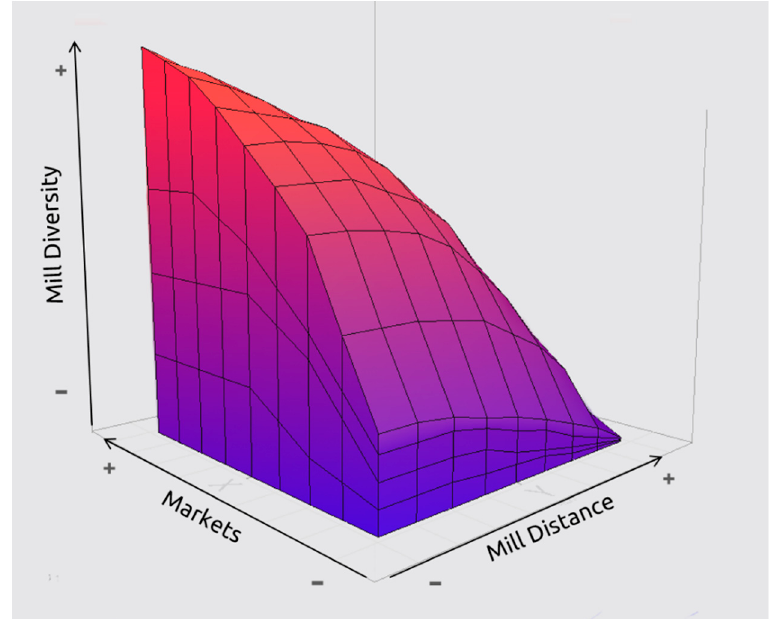
Figure 2. Illustration of economic factors influencing landowner participation in MSM. Areas on the diagram in red represent a combination of economic conditions conducive for MSM, while areas in purple represent a combination of factors where MSM is unlikely to be a viable management option. Plus signs indicate an increase in distance to nearest mill, number of local markets, and diversity of products sought by local mills. Minus signs indicate a decrease in distance to nearest mill, number of local markets, and diversity of products sought by local